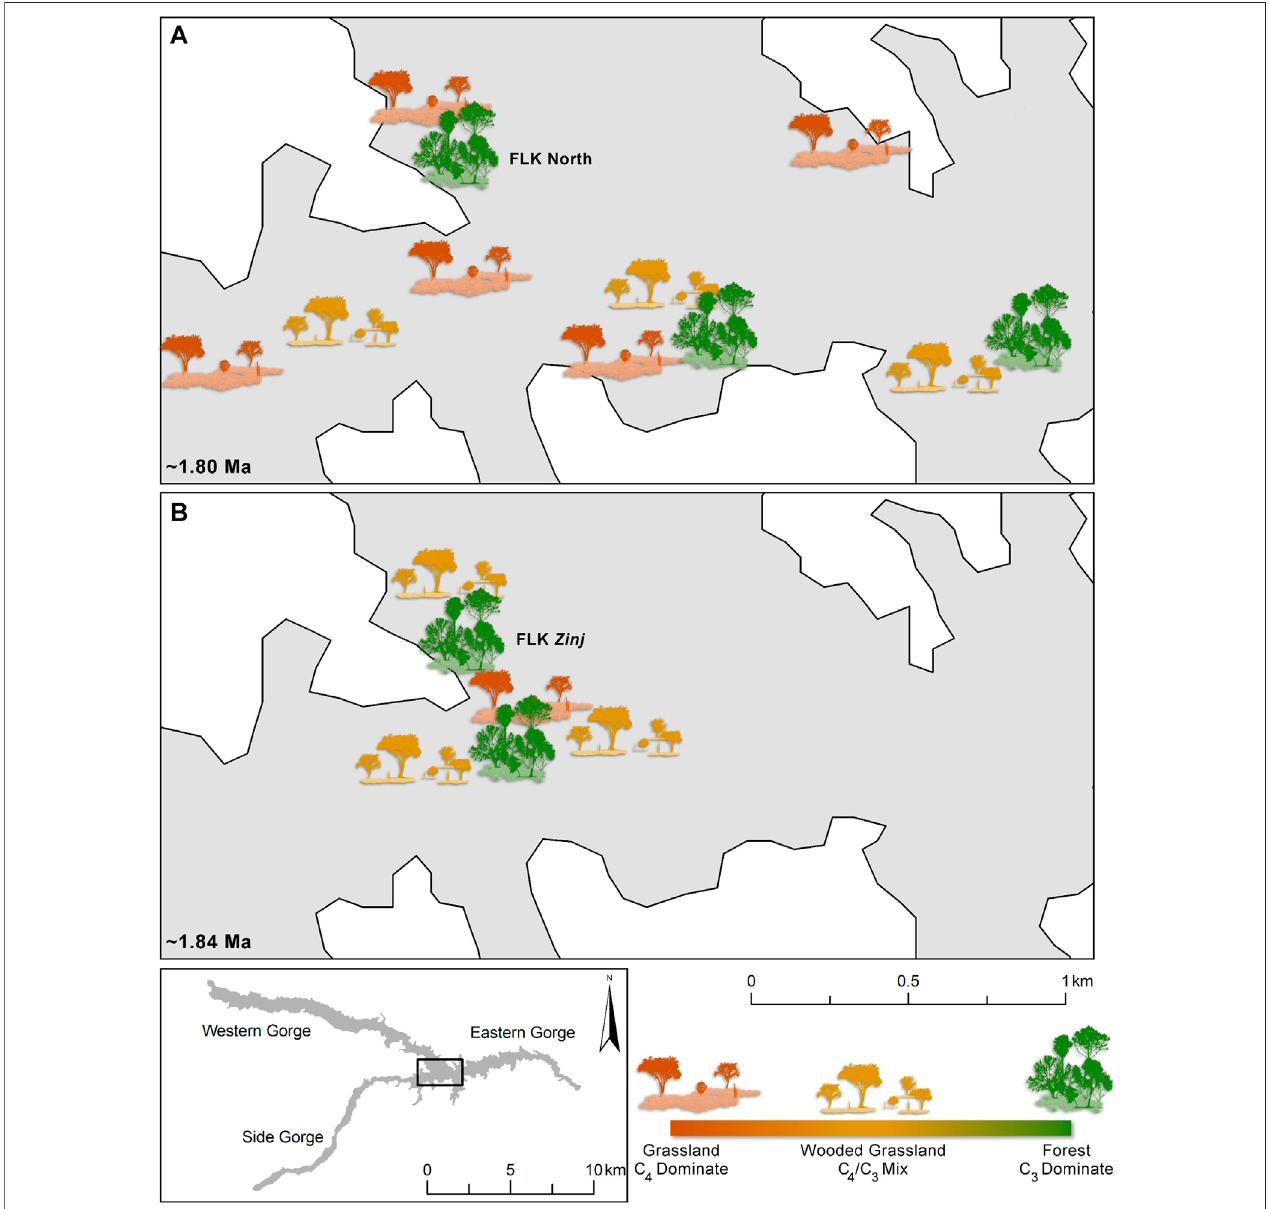
FIGURE5| MicrohabitatVariabilityatOldupaiGorgeat ∼ 1.8and ∼ 1.84 Mareconstructedfromplantwaxbiomarkerandphytolithanalyses. (A) Datafromtheclays directlybelow ∼ 1.8 MaTuffIF(Itambu,2019;Patalano,2019). (B) Datafromthe ∼ 1.84FLK Zinj horizon(Magilletal.,2015;Arráiz etal.,2017).Microhabitaticonsarenot to scale but rather represent the reconstructed plant landscape structure at given sampling locations based on plant proxies.